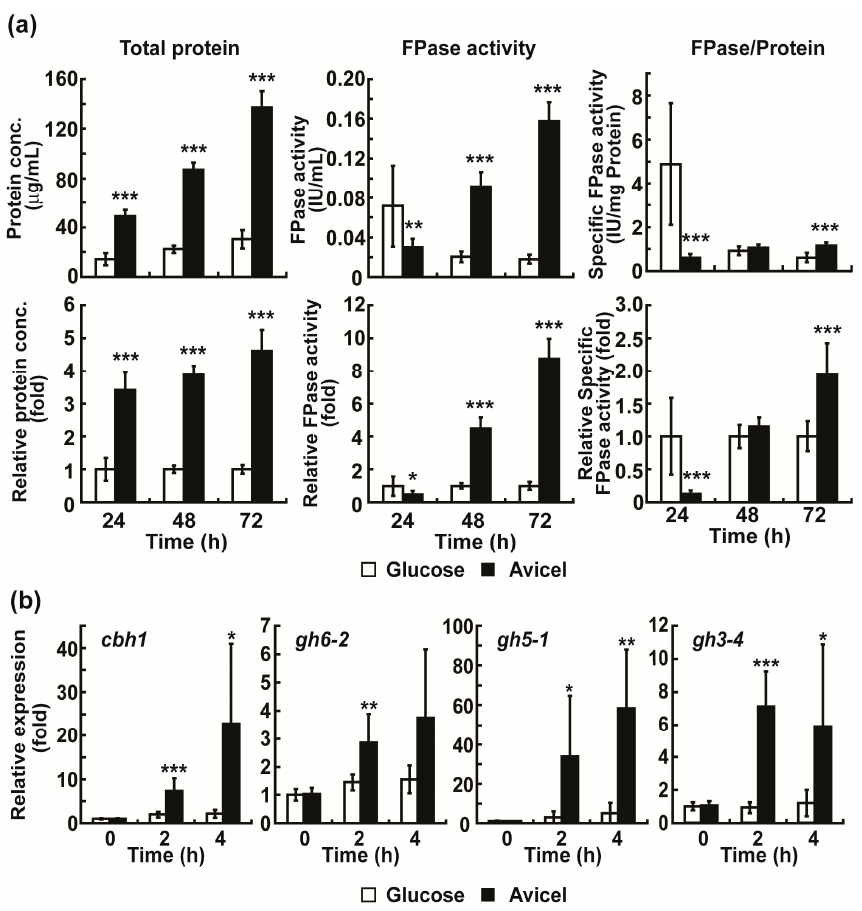
Figure 1. Analysis of activity and mRNA expression of cellulolytic enzymes. ( a ) FPase activity, total protein concentration, and specific enzyme activity were measured in media containing Avicel or glucose after 24, 48, and 72 h, and the relative fold changes between Avicel and glucose media were calculated. ( b ) mRNA levels of four cellulolytic enzymes ( cbh1 , gh6-2 , gh5-1 , and gh3-4 ) in fungal hyphae grown in media containing Avicel or glucose after 2 and 4 h. Each value is the mean of six or nine replicate measurements (three replicates per experiment and two or three independent experiments): * p < 0.05, ** p < 0.01, *** p < 0.001 as determined by Student’s t -test.